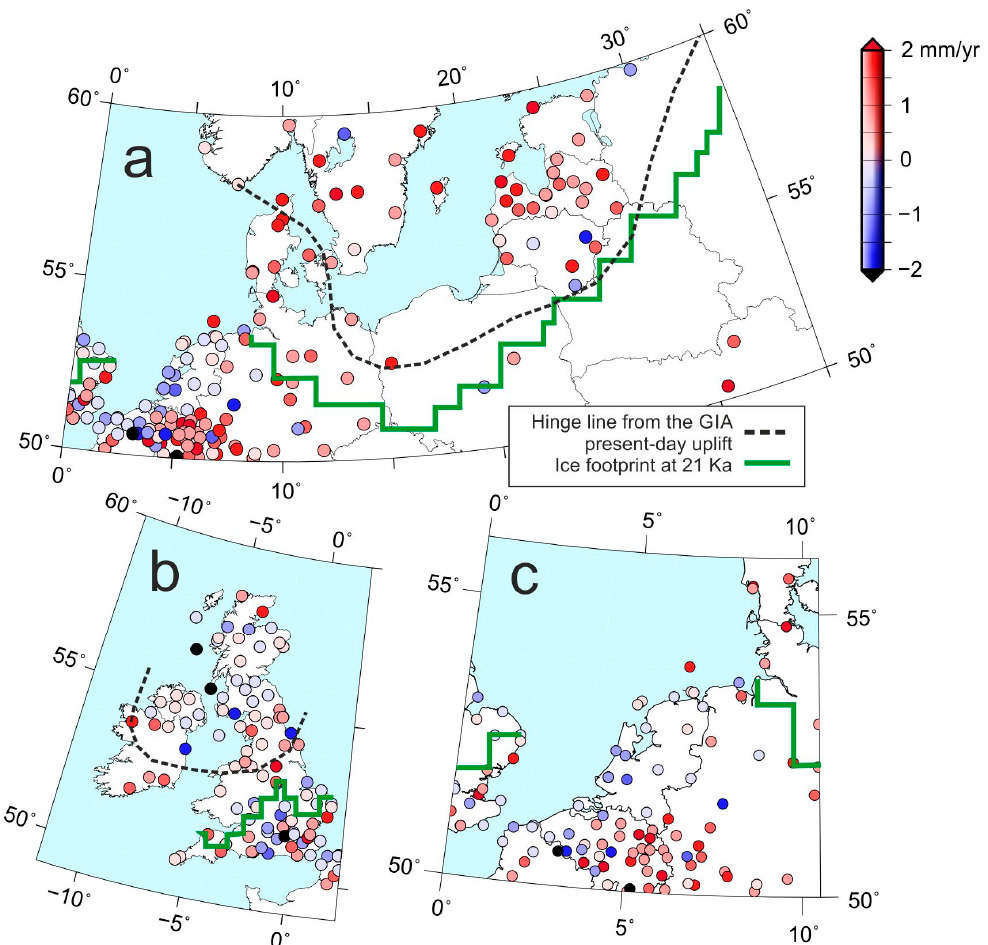
Figure 10. The differences between the GPS-derived vertical rates and the uplift predicted by the ICE- 6G GIA model at the GPS station coordinates. The hinge line, constructed based on the present-day GIA uplift, and the ice footprint at the time 21 Ka are plotted with the dashed and green lines, respectively.